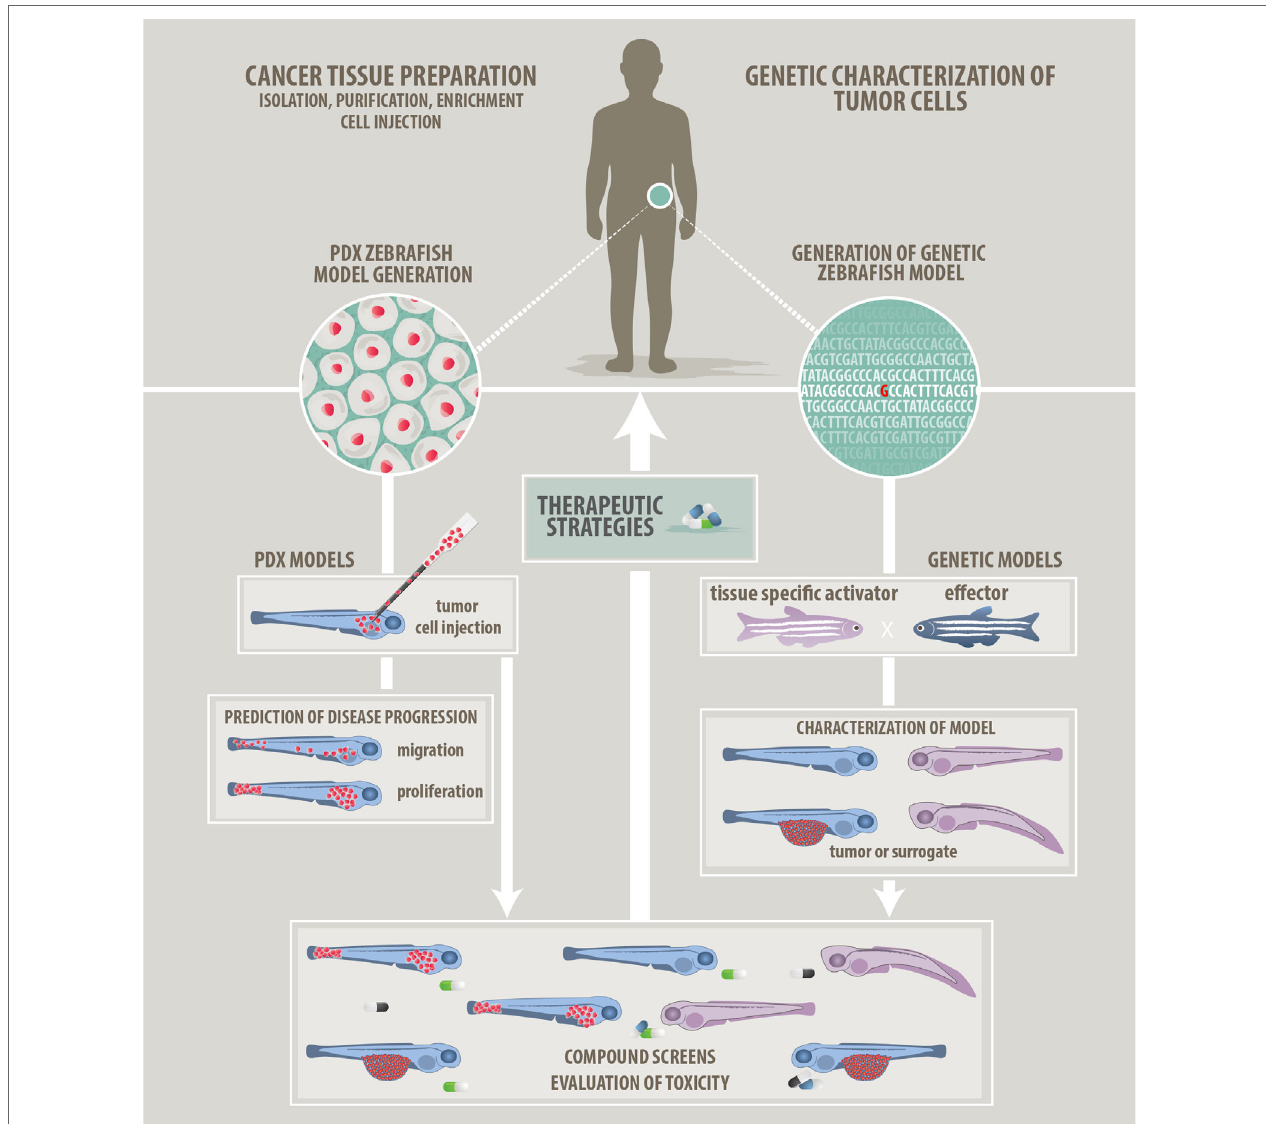
FiGuRe 1 | Approaches to modeling cancer in zebrafish. We describe two main approaches how zebrafish can be used in cancer research and how zebrafish will help to develop patient-tailored therapies in the future. ( Left panel ) Patient-derived xenograft approach : cancer cells prepared from resected or isolated patient material will be transplanted into zebrafish larvae. Monitoring of in vivo proliferation, migratory behavior, and interaction with host cells like endothelial cells might allow predictions of aggressiveness and disease progression. ( Right panel ) Genetic modeling approach : bioinformatic analyzes of Omics data will point at candidate target genes. Genetic models featuring single or combined mutations will be generated using the zebrafish tool kit. Genetic models will be used for in vivo investigation of tumorigenesis. In addition, a screenable phenotype will be identified. This can be an actual tumor, hyperproliferating cells, or developmental abnormalities. Studies of the tumor microenvironment are also possible on genetic models. ( Common middle panel ) Compound evaluation, compound screens, and development of therapeutic strategies : testing of single compounds, compound synergies, evaluation of toxicity, and screening for new compounds will help to advise on optimized and in the future individualized